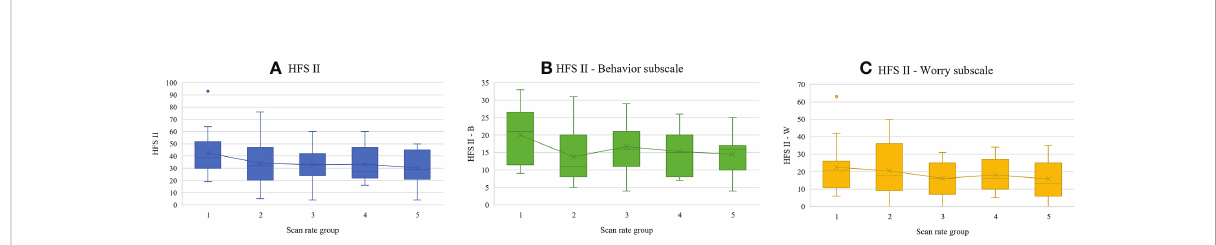
FIGURE 3 Fear of hypoglycemia across scan rate groups (each group represents 20% of subjects ( fi rst 2 groups – n=16, next 3 groups – n=15). (A) HFS II, (B) HFS II - Behavior subscale, (C) HFS II - Worry subscale. Data shown as mean and interquartile range.